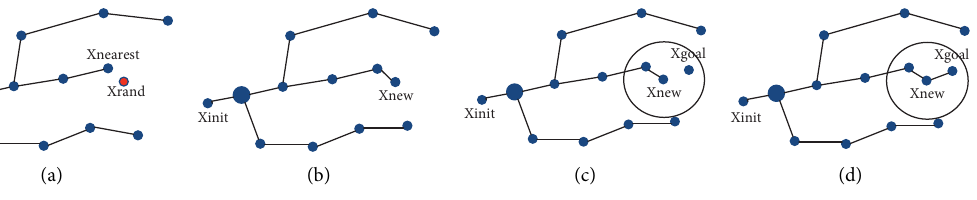
Figure 1: RRT algorithm schematic diagram.